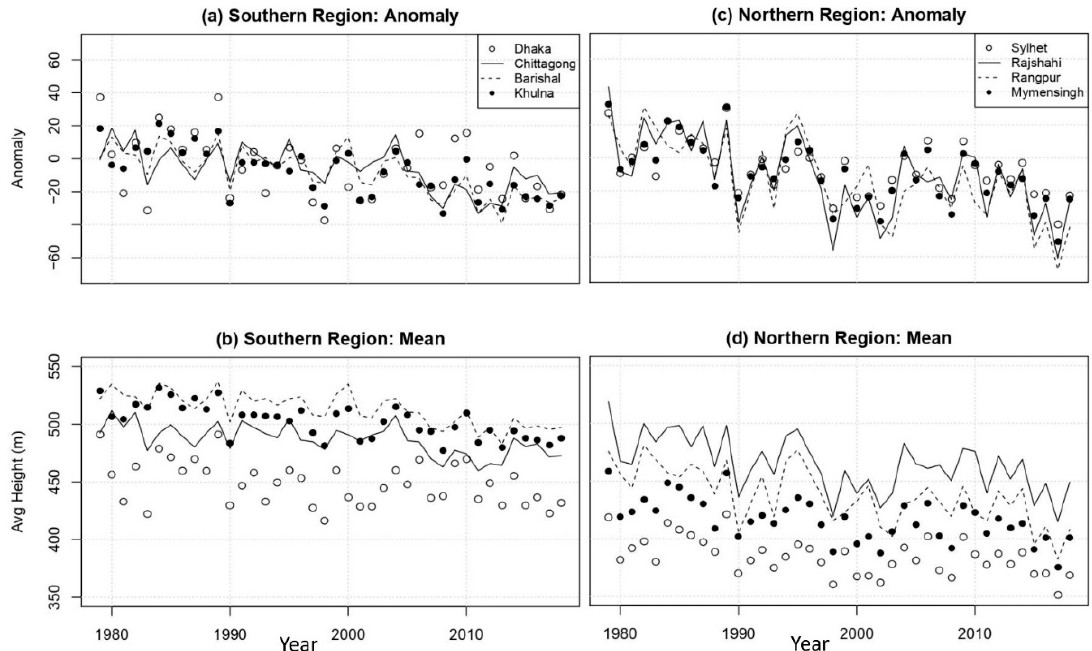
Figure 5. Time series of atmospheric boundary layer height (m) for the southern (left panels) and northern regions (right panels) averaged from 1979 to 2018 with a climatic base period of 1979 to 2000.